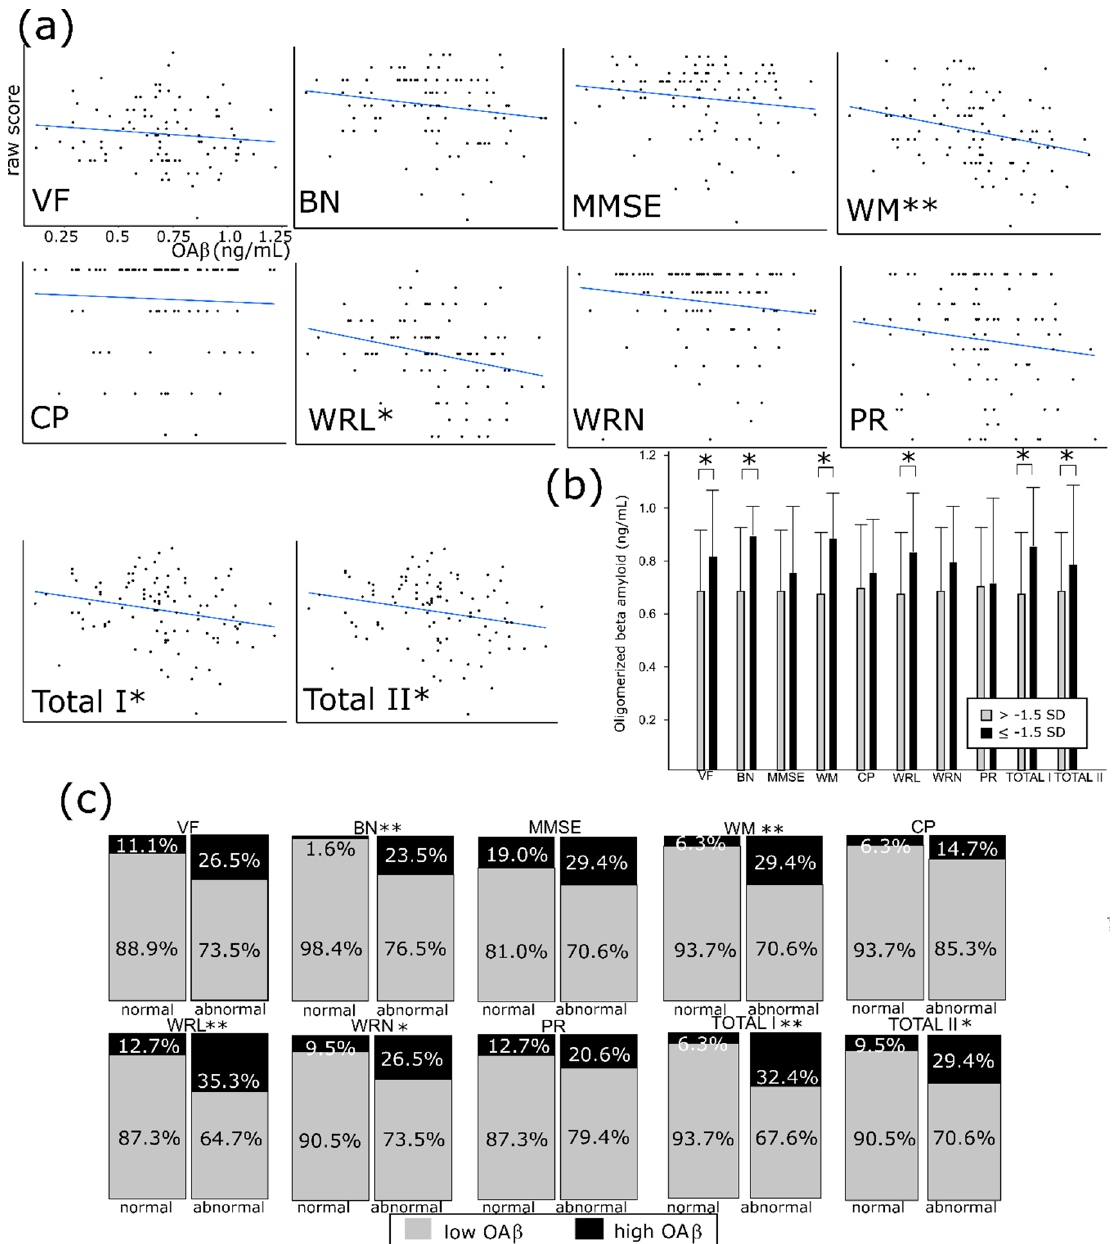
Figure 2. The subtests of the Korean version of Consortium to Establish a Registry for Alzheimer’s disease (CERAD-K) and plasma oligomerized beta amyloid (OA β ). ( a ) Raw scores of the CERAD-K and OA β concentration. ( b ) The abnormal CERAD group (below − 1.5 standard deviation of age/sex/education adjusting norms) in verbal fluency, naming, word memory/recall, and total scores showed higher OA β concentration compared with control. ( c ) Abnormality in naming, word memory/recall/recognition, and total scores are significantly more frequent in high OA β groups ( ≥ 0.78 ng/mL). SD—standard deviation; VF—verbal fluency; BN—Boston naming; MMSE—mini-mental status examination; WM—word list memory; CP—constructional praxis; WRL—word list recall; WRN—word list recognition; and PR—praxis recall. Total I is a sum of subtests except MMSE and PR and Total II is a sum except MMSE. * p < 0.05. ** p < 0.01.